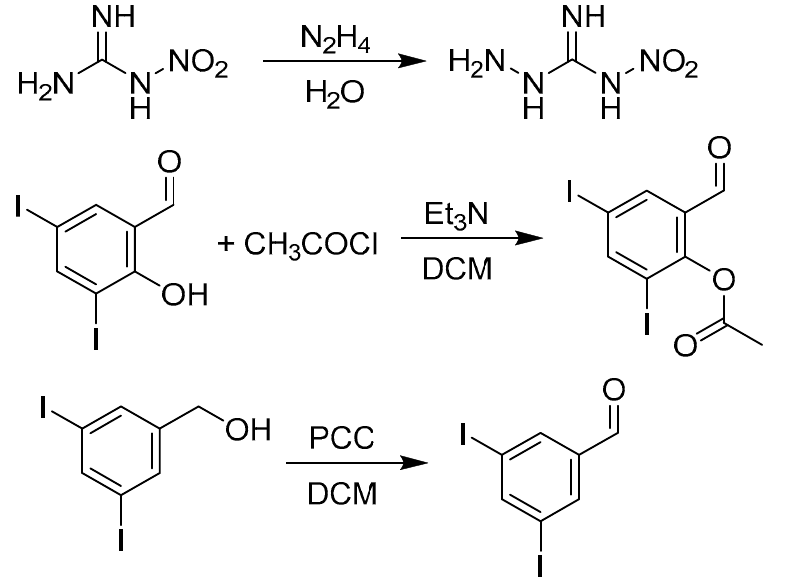
Figure 7. Preparation of synthetic precursors (PCC: pyridinium chlorochromate; DCM: dichloro- methane).